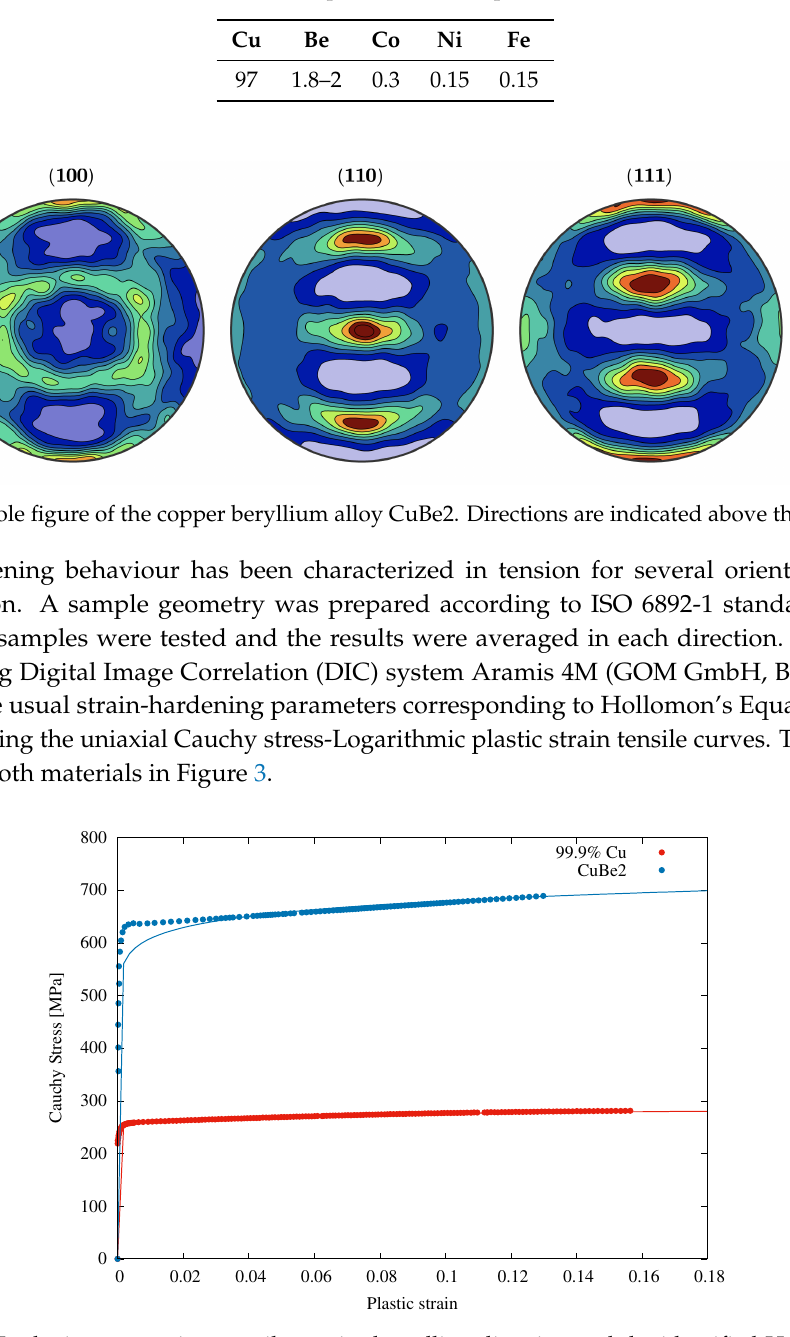
Table 1. Chemical composition in mass percent of CuBe2.